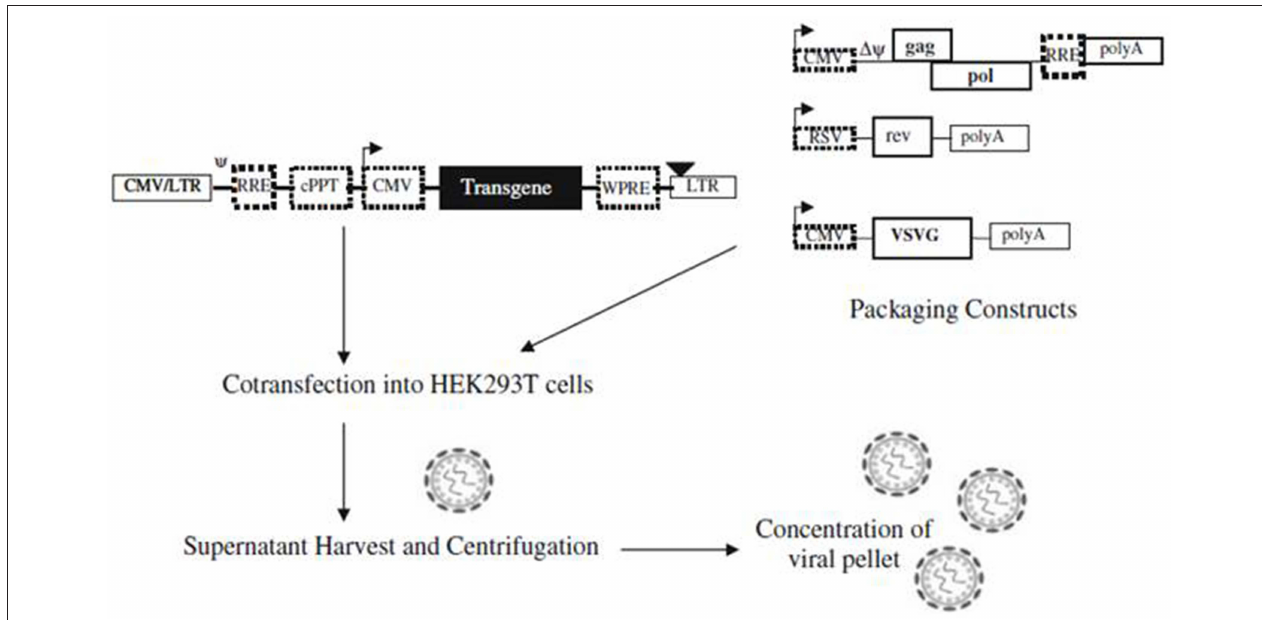
FIGURE 2 | A schematic illustration showing production of lentiviral vectors. Lentiviral vectors are produced via co-transfection of packaging constructs and shuttle vector, containing the transgene, on packaging cell line (e.g., HEK293T). Viral particles are formed upon co-transfection and released into the supernatant via budding process, which can be concentrated before transduction into target cells. Reproduced with permission from Howarth et al.